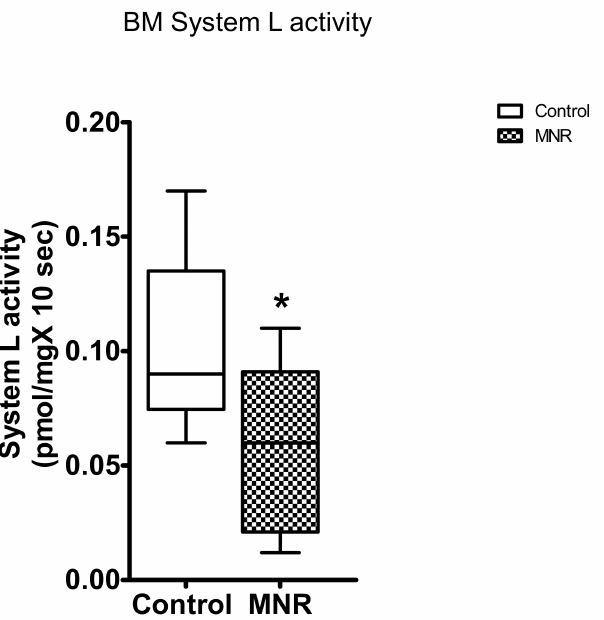
Figure 7. Basal plasma membrane (BM) leucine transport in control and MNR group at GD 140. System L involved L-leucine uptake into BM vesicles isolated from placentas of control and MNR group. BM leucine transport in Control and MNR groups was compared using the Mann–Whitney test ( n = 9/each group, * p < 0.05, Medians ± IQR). KS normality test p -value: BM system L activity (Control, p > 0.10; MNR, p > 0.10; passed